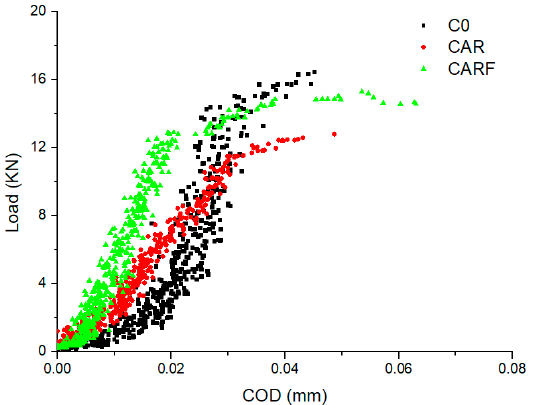
Figure 12. The load–COD curves of specimens with different toughening materials. Table 3. Characteristic parameters of specimens.